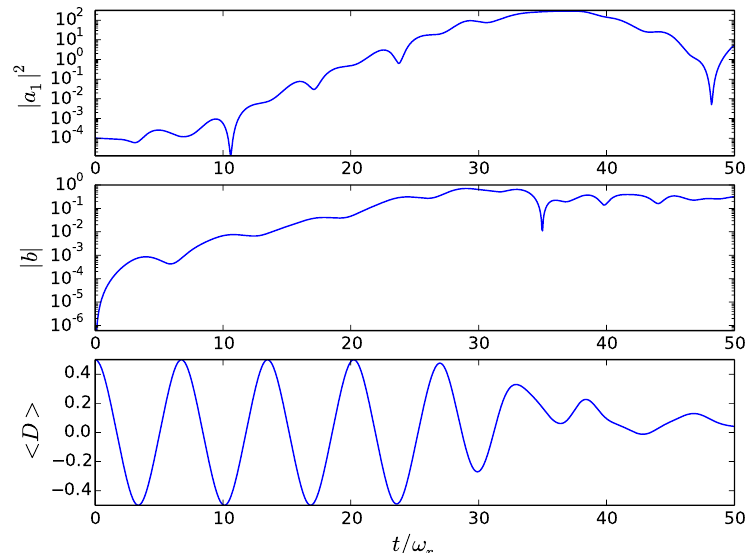
| 2 , bunching parameter, | b | , and mean 1